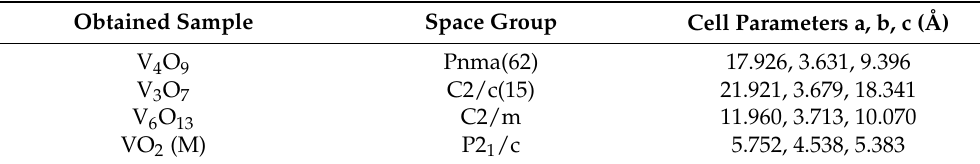
Figure 1. XRD data of ( a ) S1 (reactants ratio 0.5:1) and ( b ) S2 (reactants ratio 1:1) samples. Table 1. Crystallographic data of different products in the sample.